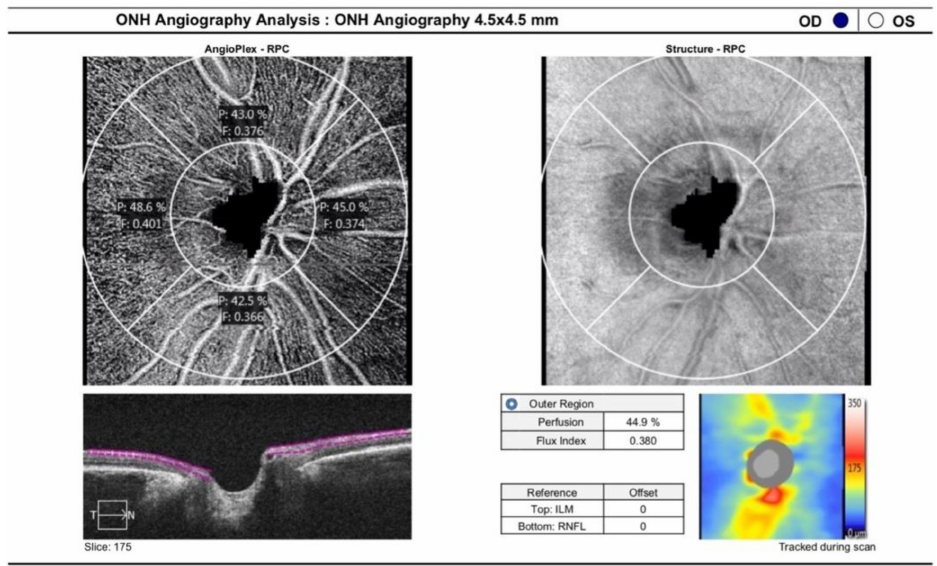
Figure 4. ONH angiography 4.5 × 4.5